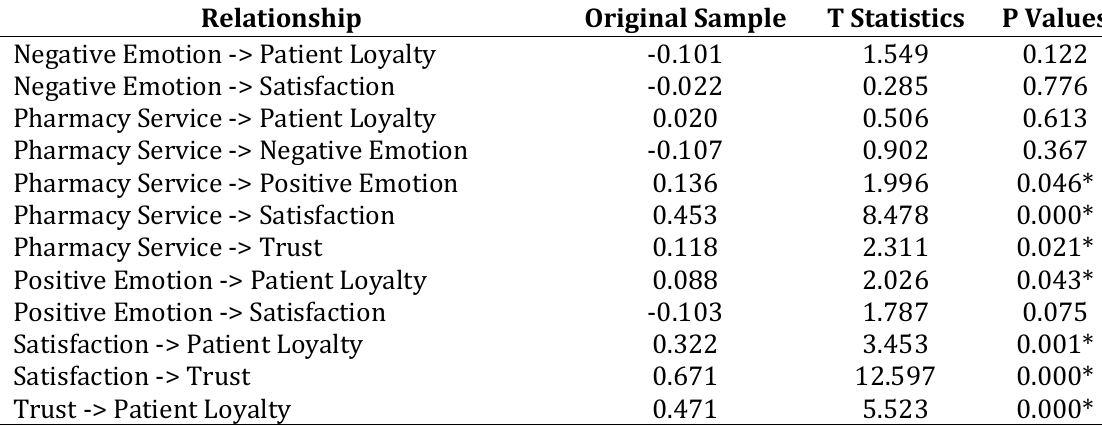
Table III. Hypotheses Testing Relationship